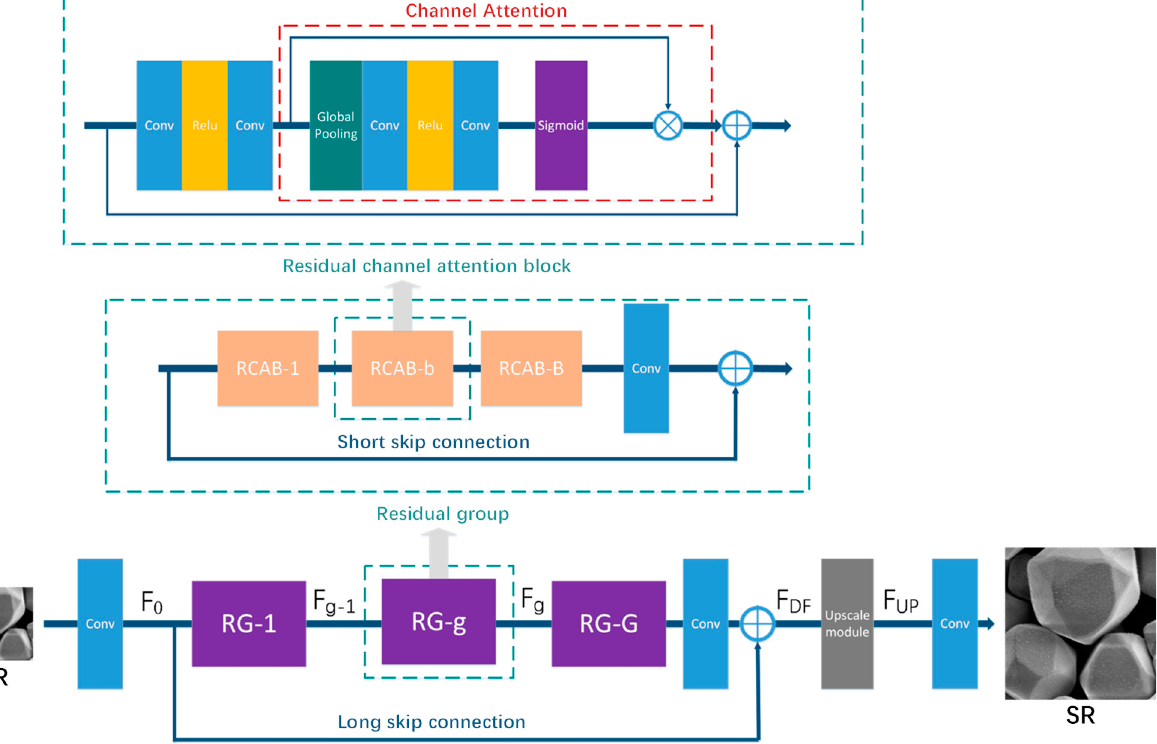
Figure 1. Architecture of the generator network which formed by residual in residual (RIR) structure. Channel attention (CA) mechanism integrated into residual block (RB) to form a residual channel attention block (RCAB). 20 RCAB with short skip connection (SSC) formed a residual group (RG). RIR structure consisted of 10 RG blocks and a long skip connection. This generator architecture can synthesis highly accurate SR images in the task.